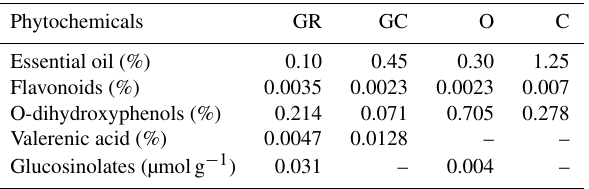
Table 1. Chemical composition of some active substances in pow- dered plant